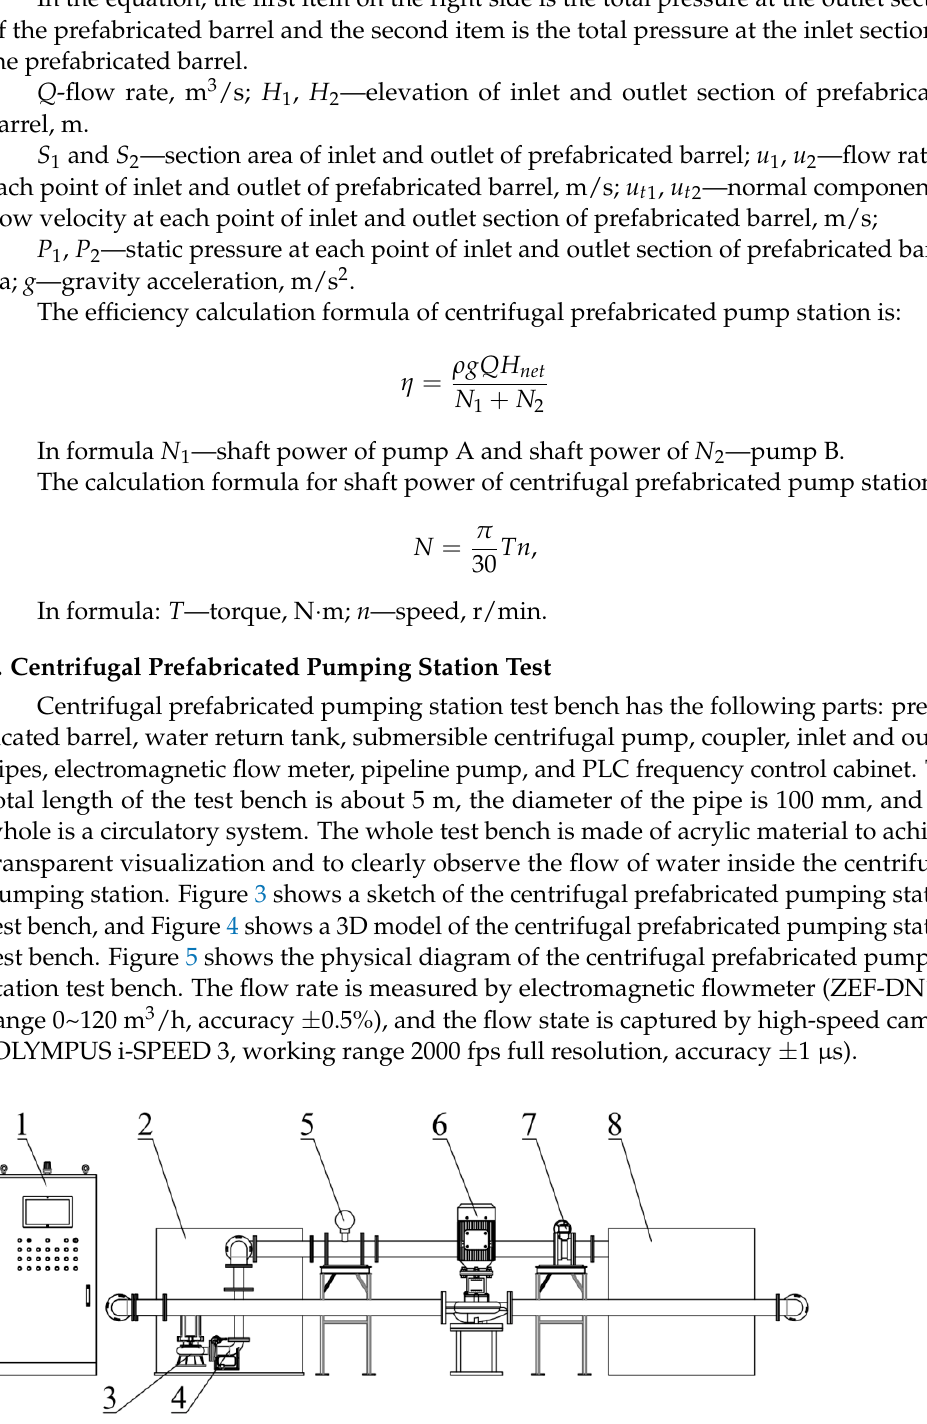
Figure 3. Sketch of centrifugal prefabricated pumping station test bench: 1. PLC frequency